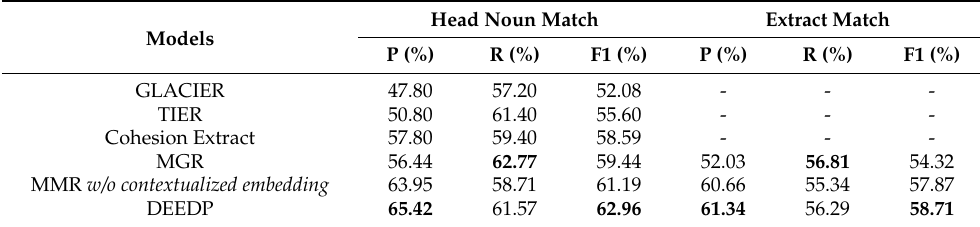
Table 2. Overall precision (P), recall (R) and F1 scores evaluated on the MUC-4 test set.